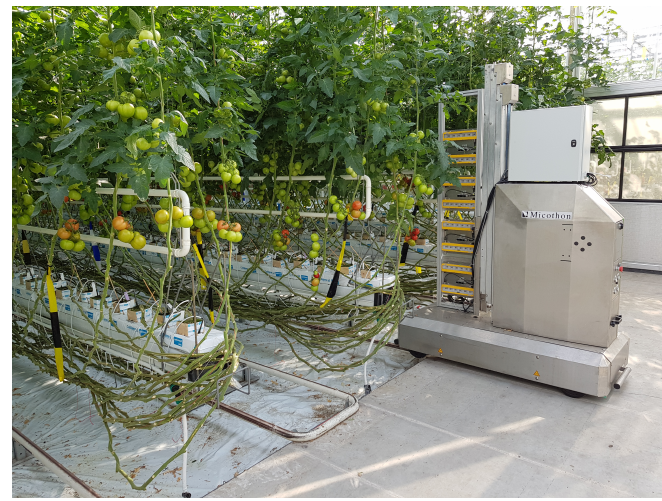
Figure 1. The Phenobot in its starting position in the greenhouse.